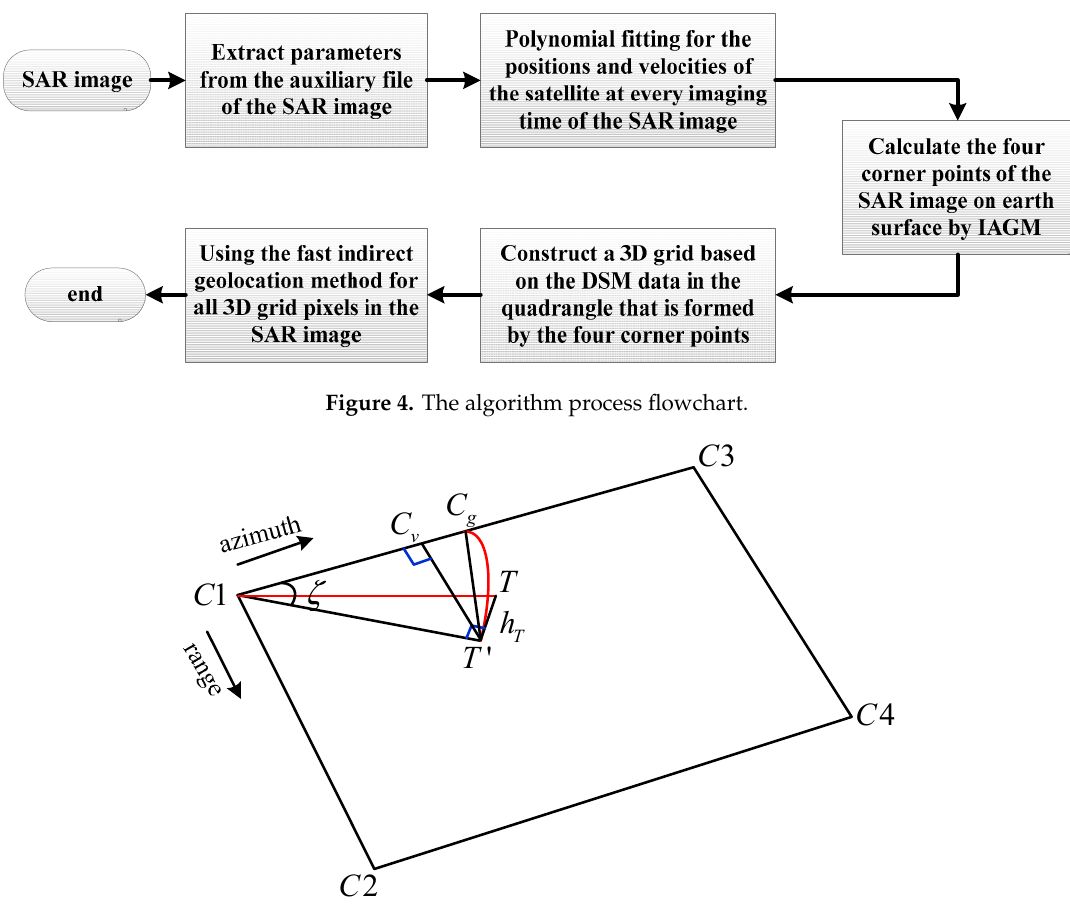
Figure 5. The geometric illustration of the estimated azimuth time.